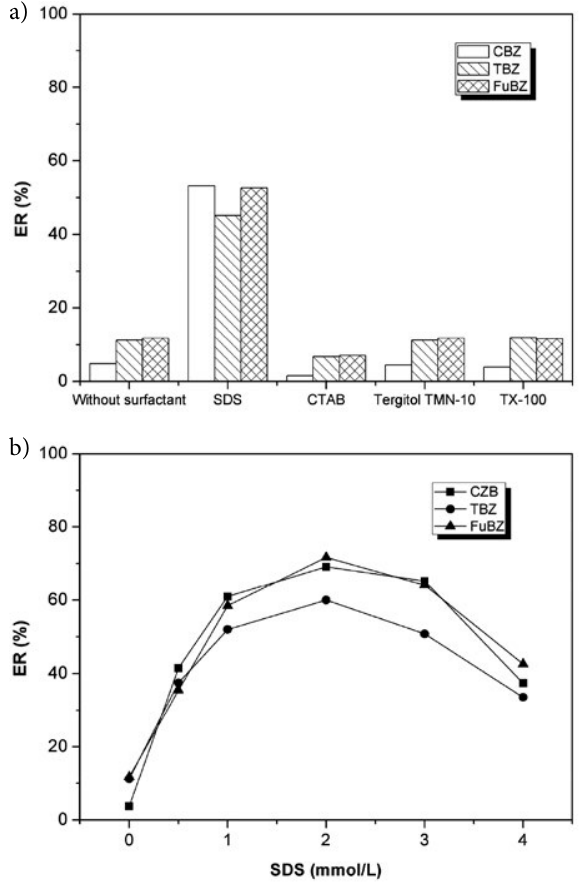
Figure 1: Effects of (a) surfactant and (b) SDS on the extraction recov- ery of the target